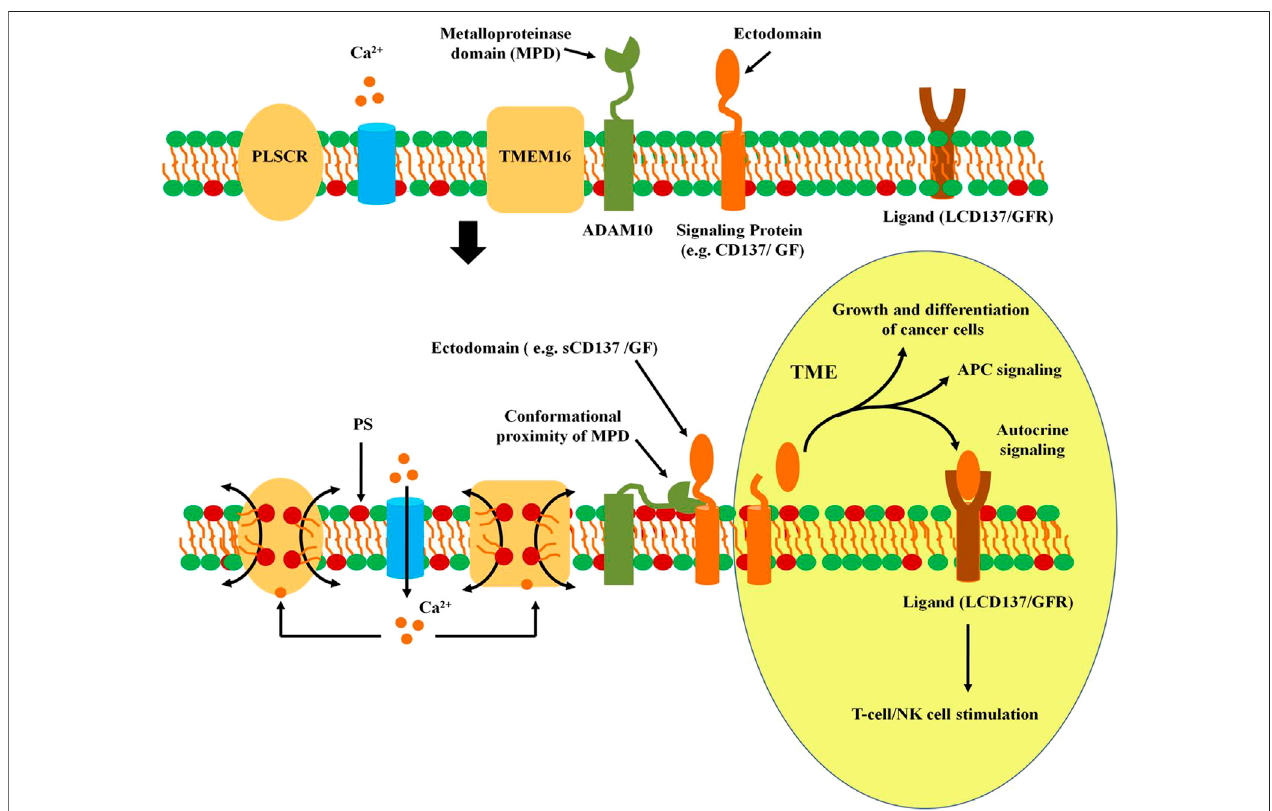
FIGURE 2 | Activation of ADAM sheddase activity. In non-activated quiescent cells, the metalloproteinase domain of ADAM10 remains distant from the signaling membraneprotein.However,entryofCa 2+ intothecytoplasmactivatesPLSCRsandTMEM16scramblases,leadingtoexternalizationofphosphatidylserine.Interaction of the exoplasmic domain of ADAM10 with PS on the surface of plasma membrane leads to conformational alteration in the MPD increasing it ’ s proximity with the membrane-localized signaling protein. The proteinase acivity in MPD releases the ectodomain that serves as a signal for other tumor cells or immunocytes in the TME. The ectodomain of signaling proteins such as CD137 or membrane anchored growth factor (GF). The ectodomain of CD137 (sCD137) binds to it ’ s own ligand (LCD137) that leads to autocrine stimulation of T cells or NK cells. Release of GF leads to paracrine signaling in cancer cells leading to tumor growth and